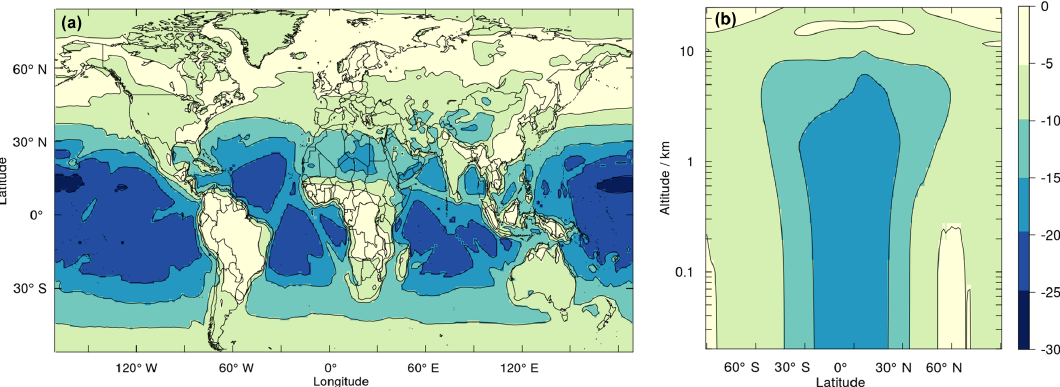
Figure 12. Annual mean percentage change in CH 3 O 2 concentrations from run 1 (relative to the base run) at the surface (a) and as a zonal mean (b)